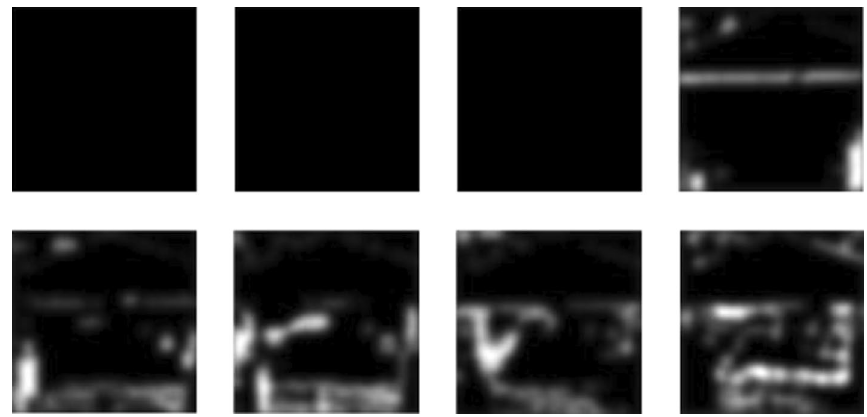
Fig. 5 Feature layers of the image after the first